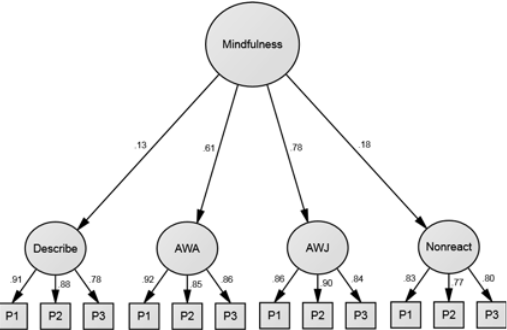
Fig 1. Confirmatory Factor Analysis results for the four-factor hierarchical model of the Five Facet Mindfulness Questionnaire [18], omitting the Observe facet, in Sample 1 ( N = 395). First-order latent variables represent the four facets and derive from item parcels (three per facet). Error terms are omitted for visual clarity. AWA = Act with Awareness; AWJ = Accept w/o Judgment; P1 to P3 = Parcels 1 to 3. All standardised coefficients are significant at the .05 level, with the exception of the path from Mindfulness to Describe, which did not reach significance ( p =